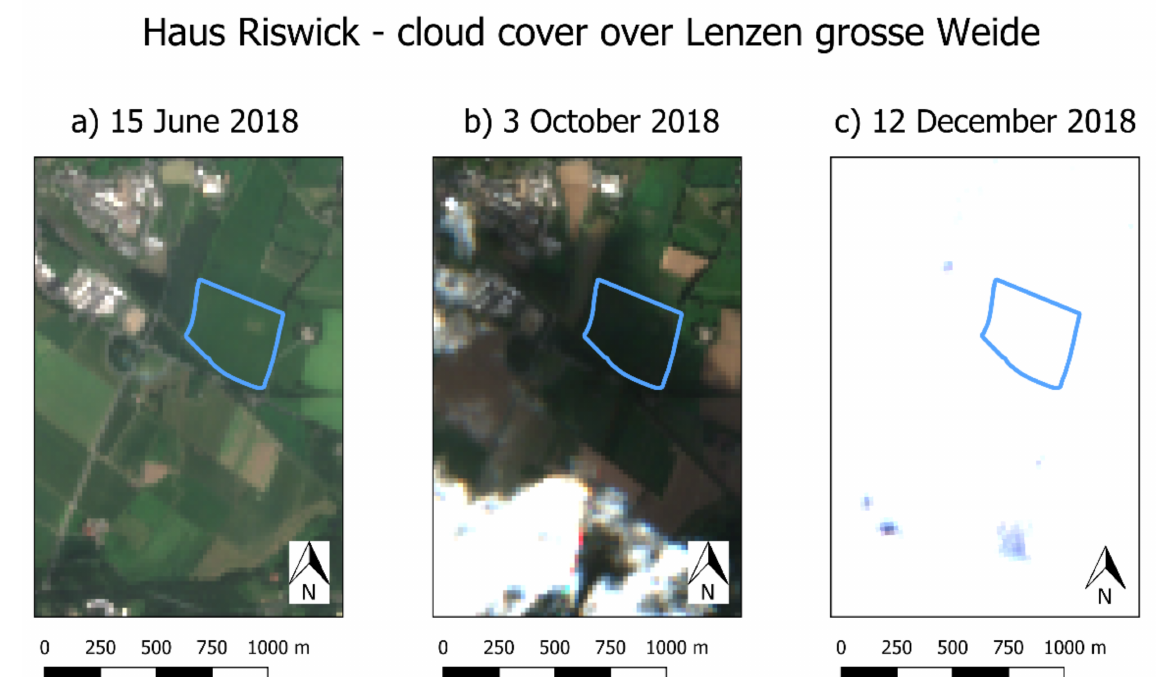
Figure 6. Cloud cover over Haus Riswick’s Lenzen grosse Weide parcel: cloud-free ( a ); hindered by cloud shadows ( b ); and fully covered with clouds ( c